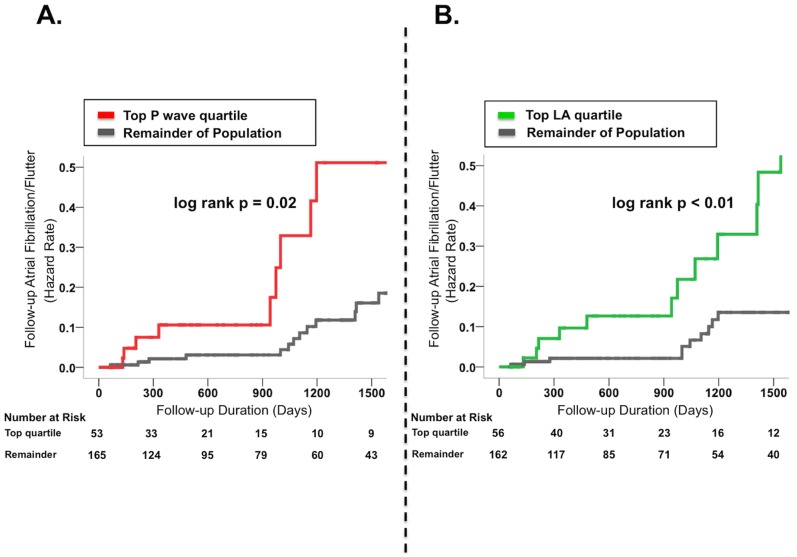
Atrial Fibrillation/Flutter Risk as Stratified by LA Remodeling Indices.Kaplan-Meier plots relating baseline P wave area (5A) and body surface area indexed LA area (5B) to follow-up risk for AF/AFl. Note that both ECG and CMR indices demonstrated increased risk for AF/AFl among patients in the highest quartile of LA remodeling.